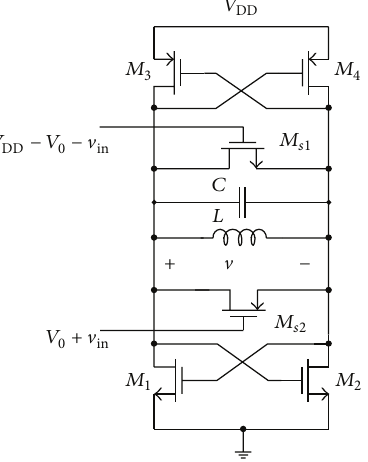
Figure 1: Circuit diagram of an injection-locked frequency divider with complementary topology and direct injection.